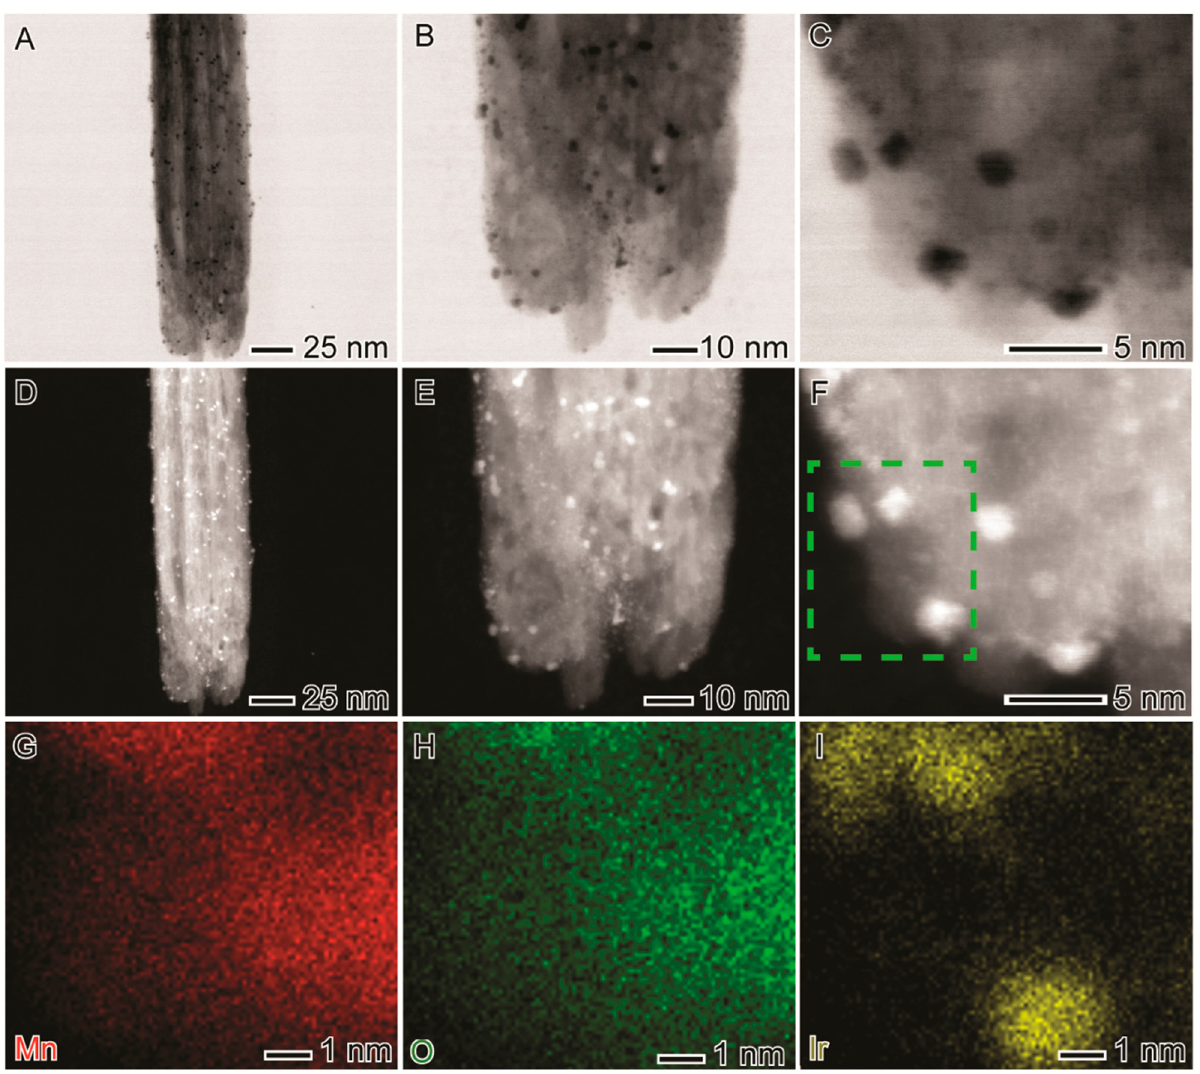
Figure 2. ( A – C ) BF-STEM, ( D – F ) HAADF-STEM, and ( G – I ) STEM-EDS maps of Mn (red, G ), O (green, H ), and Ir (yellow, I ) of the MnO 2 -Ir electrocatalyst.